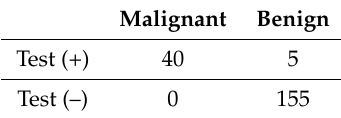
Table 1. Cross-classification: model’s prediction benign/malignant melanoma.